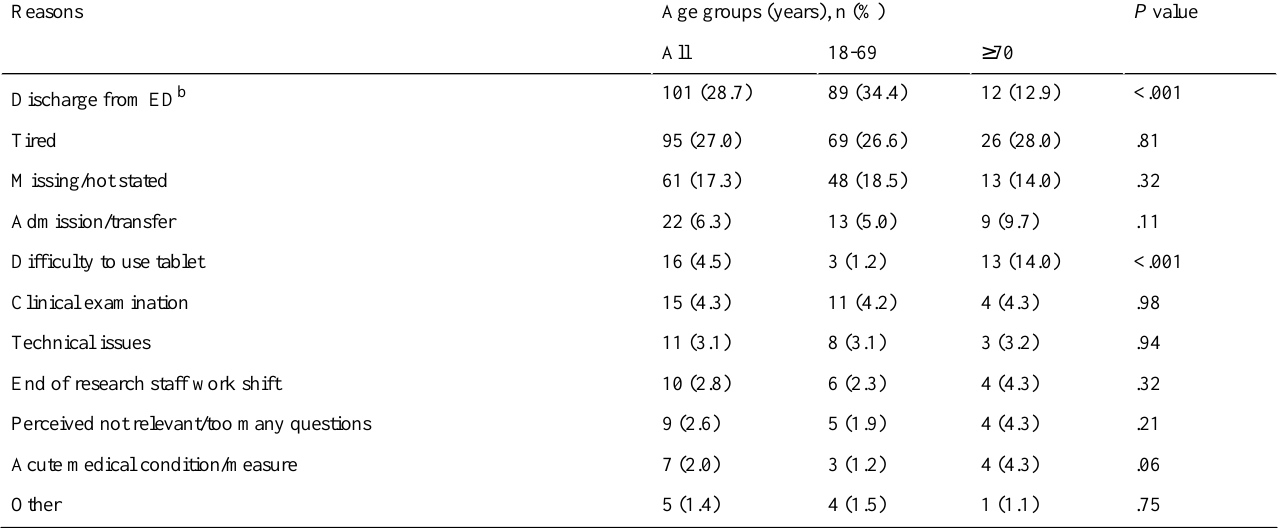
Table 4. Reasons for discontinuing the interview.